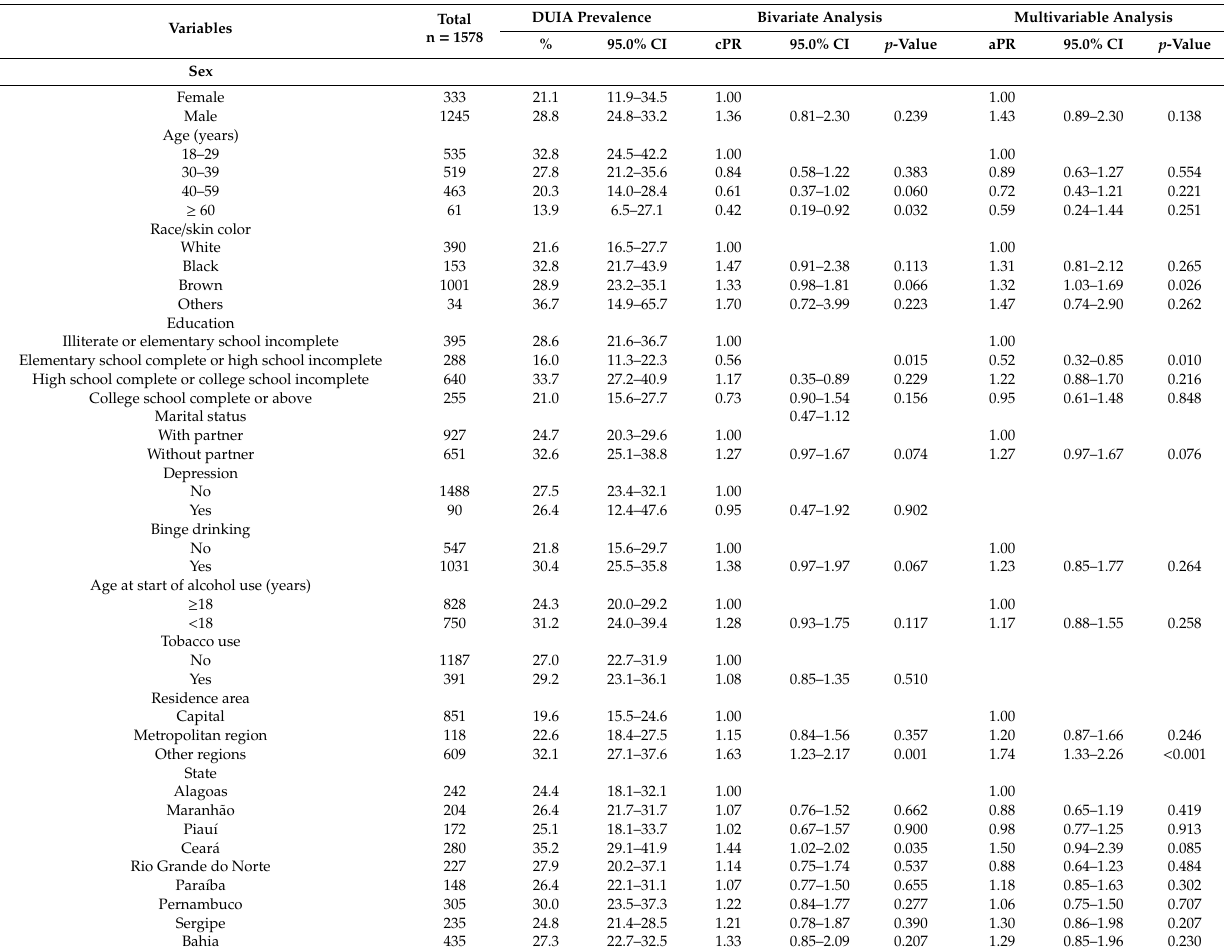
Table 6. Prevalence and Factors Associated with Driving Under the Influence of Alcohol in the North Macroregion, Brazil. National Health Survey, 2013. DUIA Prevalence Bivariate Variables Total n = 1578